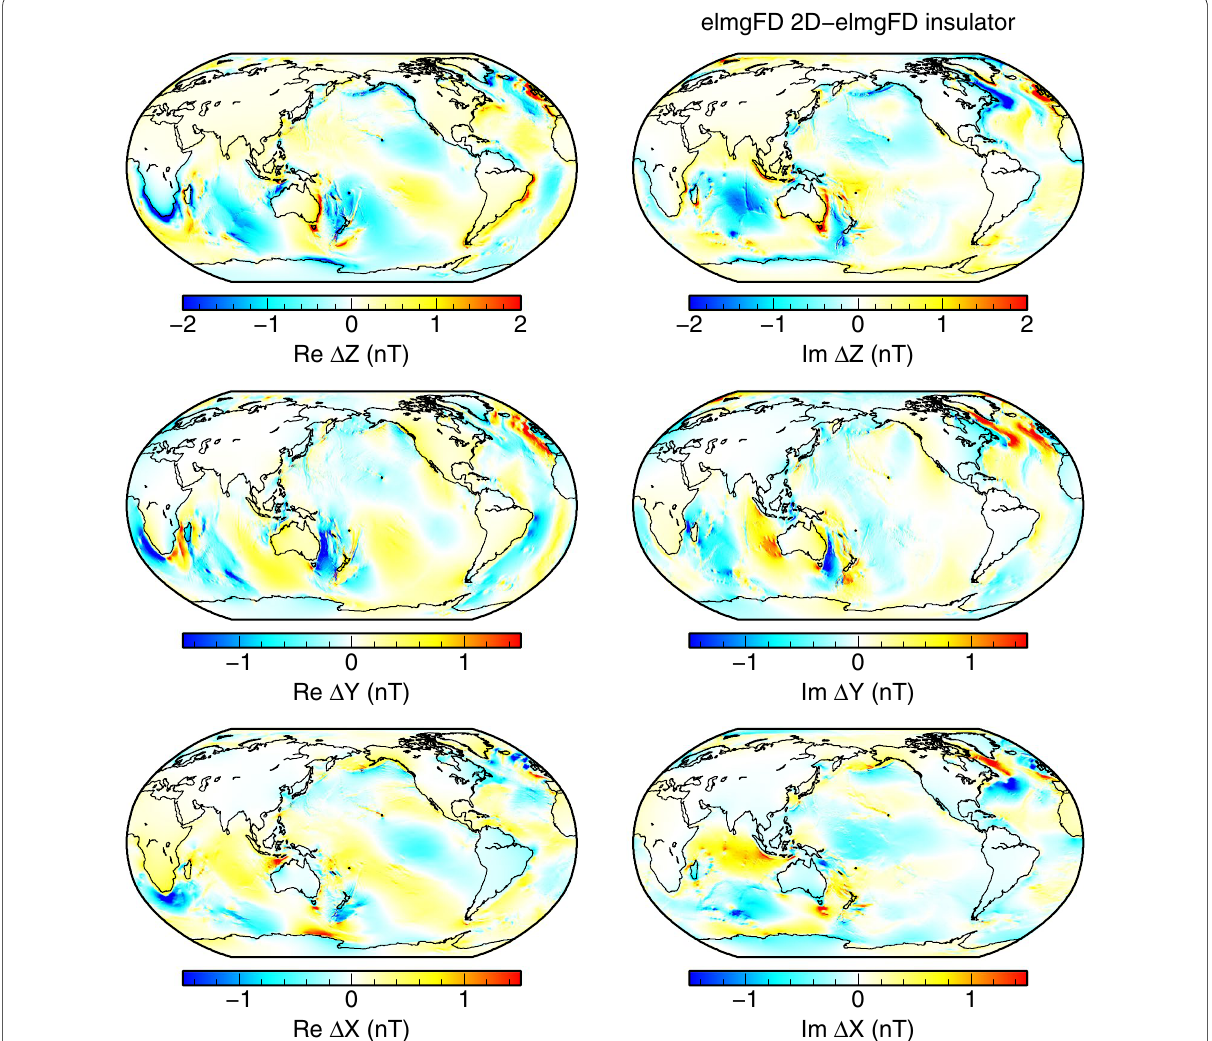
Fig. 10 Effect of insulating mantle. Differences between the 2-D solution and a solution with perfectly insulating bottom boundary condition. Both solutions were calculated at the Earth’s surface with the elmgFD code at j max =